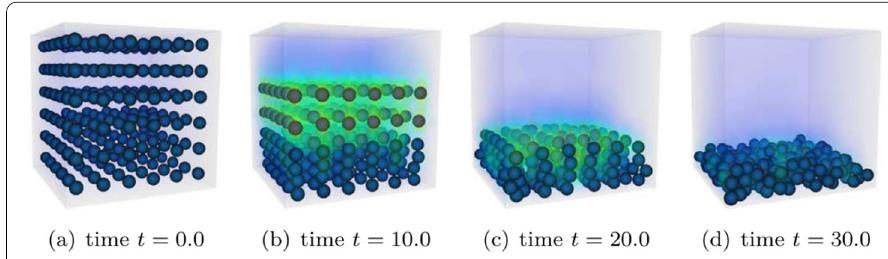
Fig. 17 Strong scaling analysis of parallel computational framework: position of spherical-shaped rigid bodies within the box for different points in time with magnitude of the velocity field ranging from 0.0 (blue) to 1.25 (red)